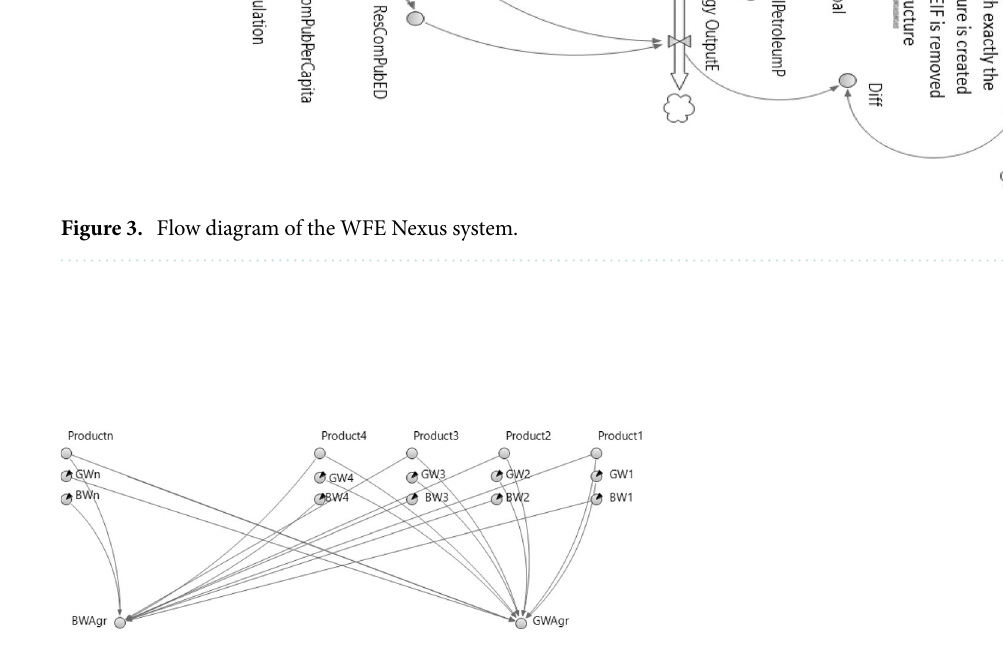
Figure 4. Agricultural subsystem modeled in the AGR agent (shows how to calculate the blue and gray water footprints of agricultural